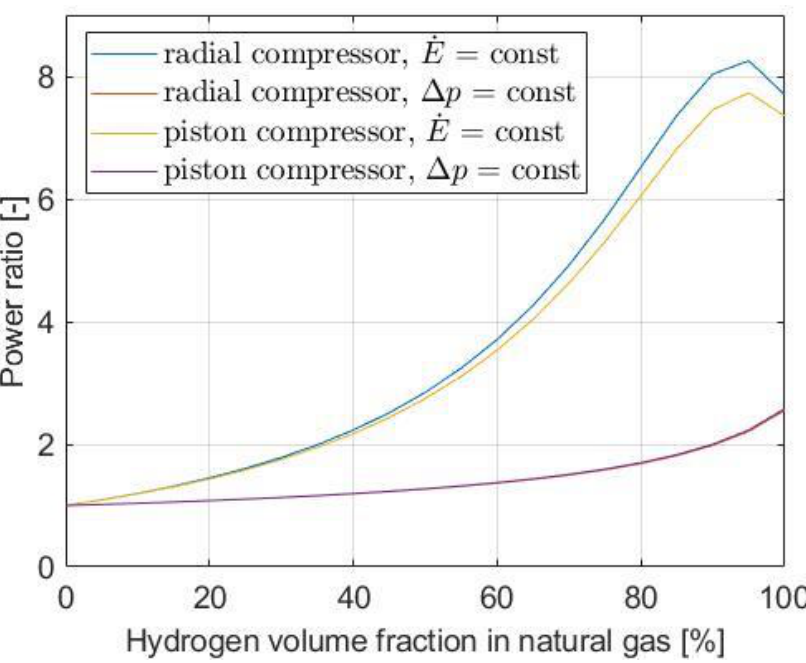
Figure 5. ( a ) Pressure drop in pipeline as a function of distance for the transport of the equal amount of energy (Scenario 1) and ( b ) pressure drop after 100 km for Scenarios 1 and 2.